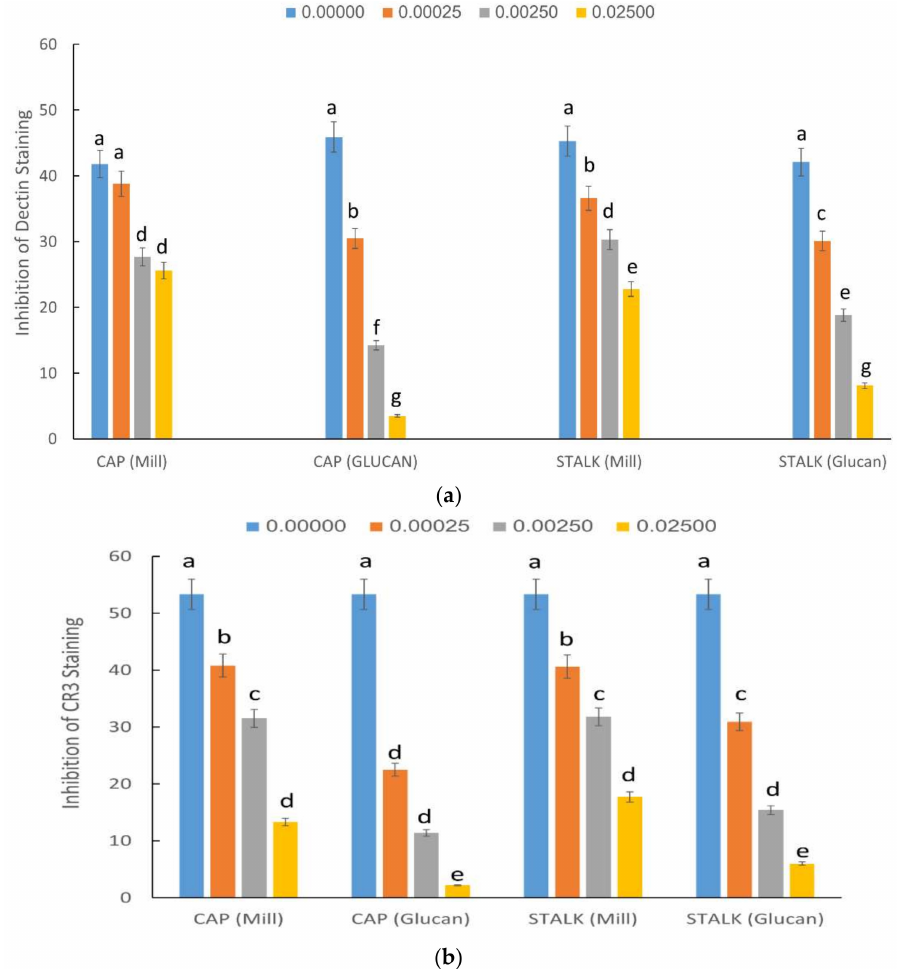
Figure 2. Effect of different concentrations of glucans from mill and isolated glucans from caps and stalks of P. eryngii mushrooms (0.00025%; 0.0025%; 0.025%; i.e., 0.25 or 2.5 or 25 µ g/1 mL media) on Dectin-1 expressed in human neutrophils ( a ) or CR3 staining expressed in RAW 264.7 cells ( b ). The data shown are the average with error bars indicating the standard deviation. The level of inhibition with increasing concentrations of P. eryngii isolated glucans is more potent than that obtained with increasing concentrations of P. eryngii mill preparations. No difference between caps and stalks. Different letters indicate significantly different values at p <